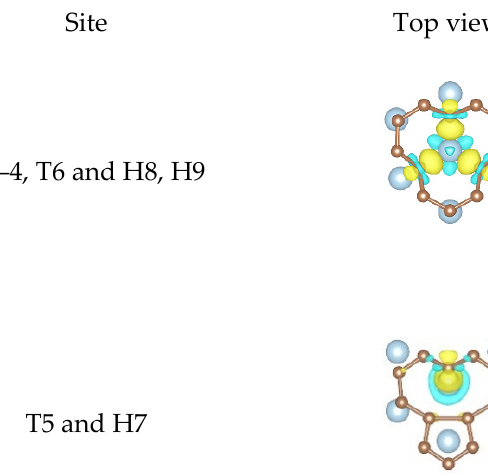
Figure 6. The local differential charge density plots at the SW defect graphene/Al (111) interface. The yellow/blue colors mark an increase/decrease of the charge density, respectively. Iso surfaces correspond to 3 × 10 − 3 e/Å 3 .